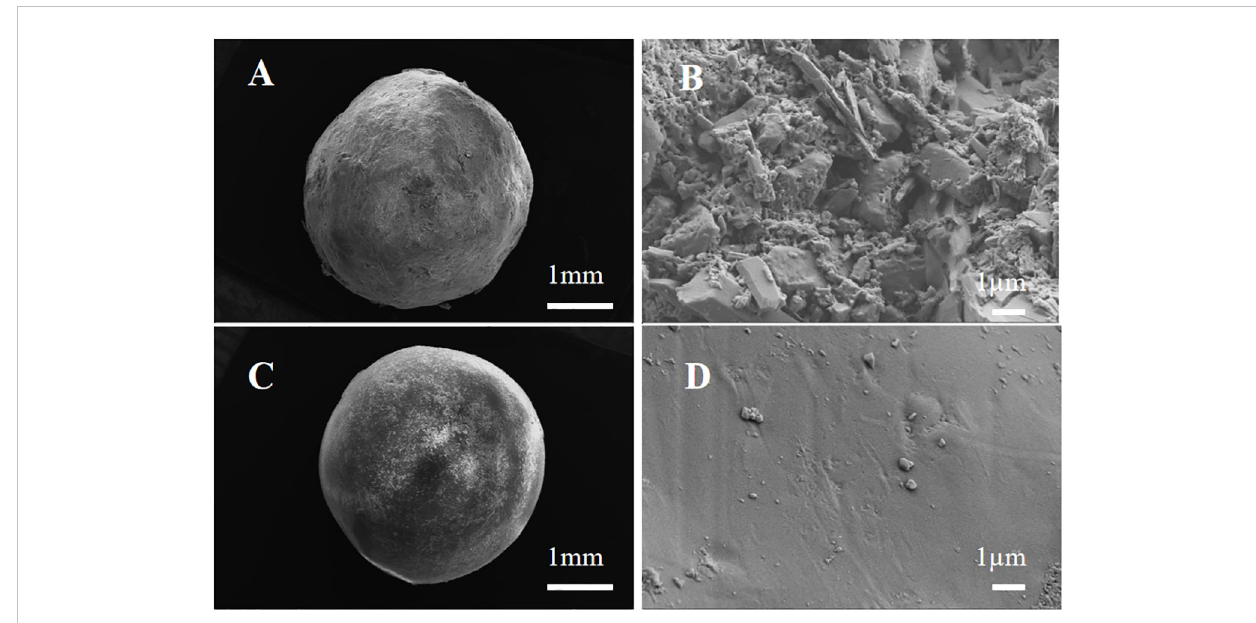
FIGURE 2 Surface scanning electron microscopy (SEM) of controlled-release N fertilizers (CRNs) with release periods of 40 d (A, B) and 90 d (C, D) .